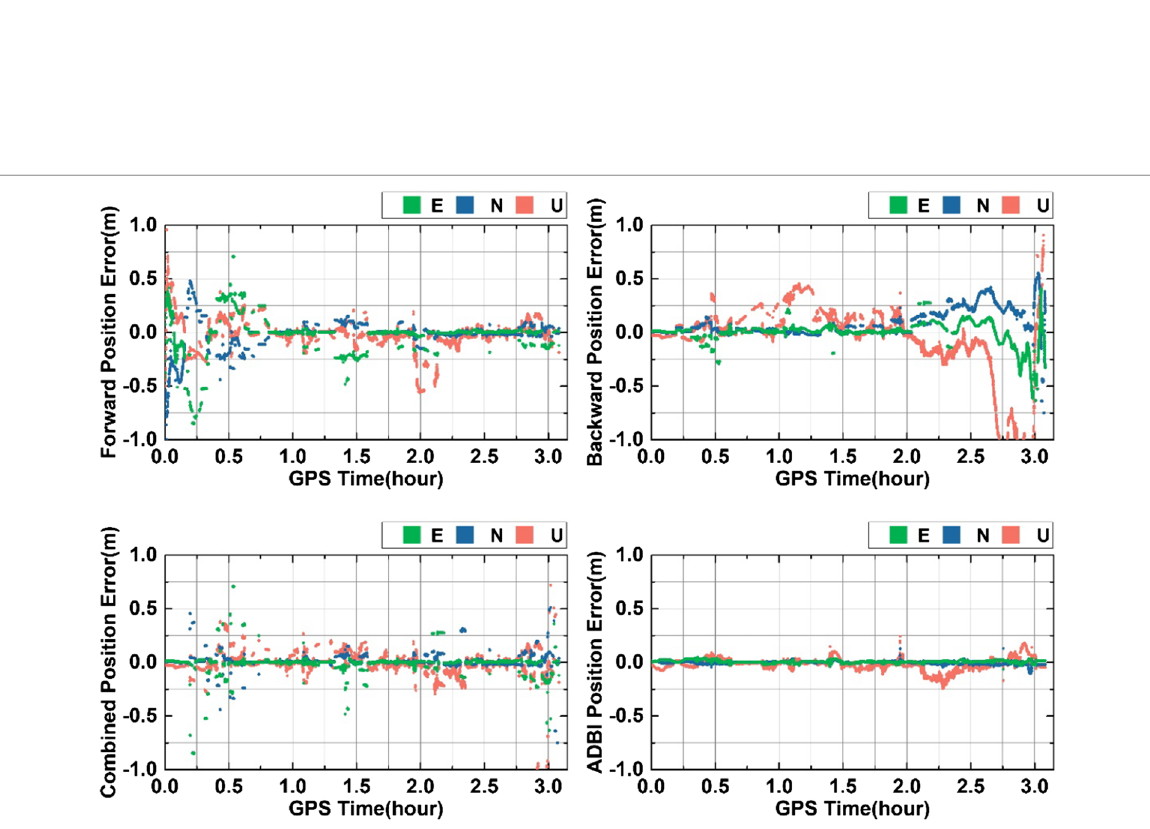
Fig. 11 Positioning biases with IF model in the forward filter ( top left ), backward filter ( top right ), post-processing results with FBC method ( bottom left ) and result with ADBI strategy ( bottom right ) using vehicular